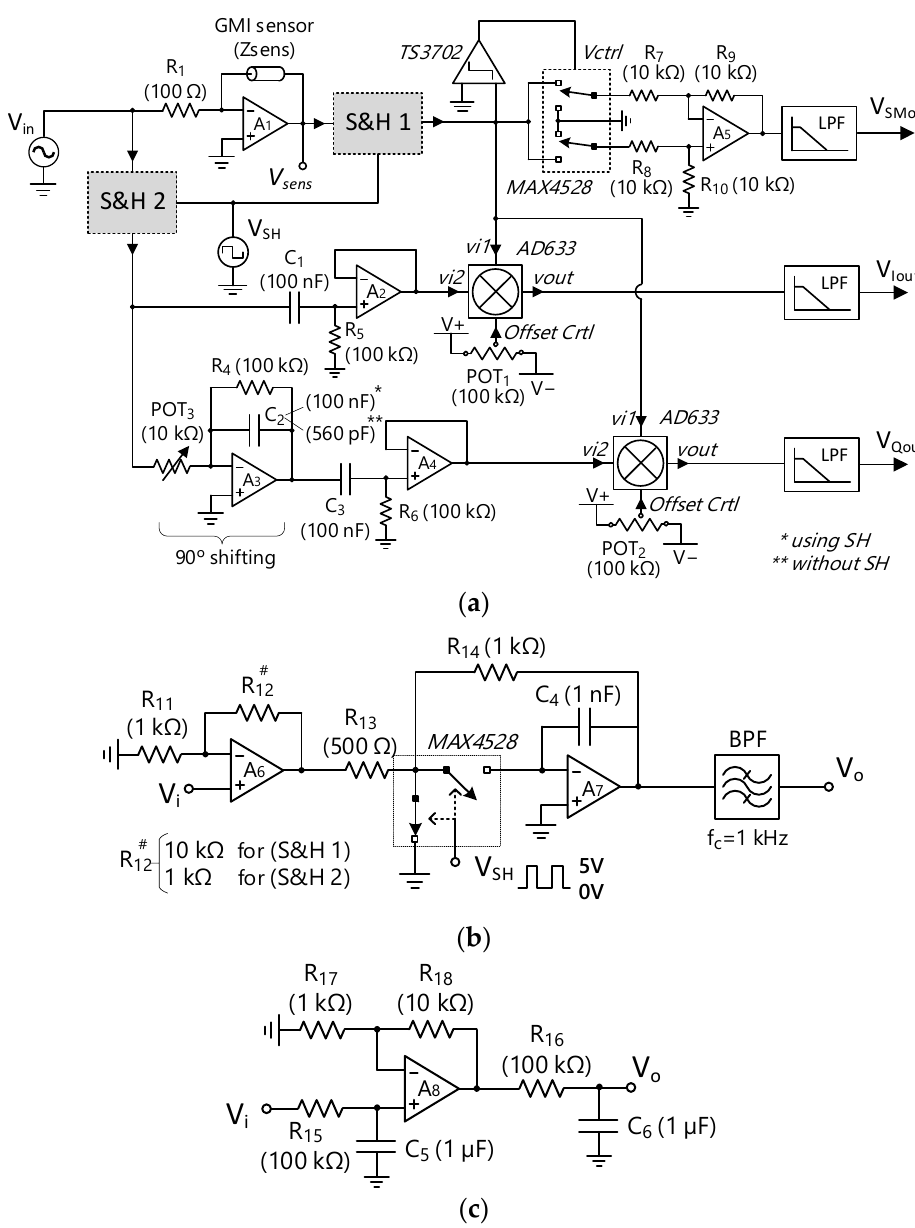
Figure 7. Complete schematic of the proposed system: ( a ) circuit containing the GMI sensor interface together with both proposed LIA architectures; ( b ) schematic of the SH; and ( c ) schematic of the low-pass filter at the LIA outputs.